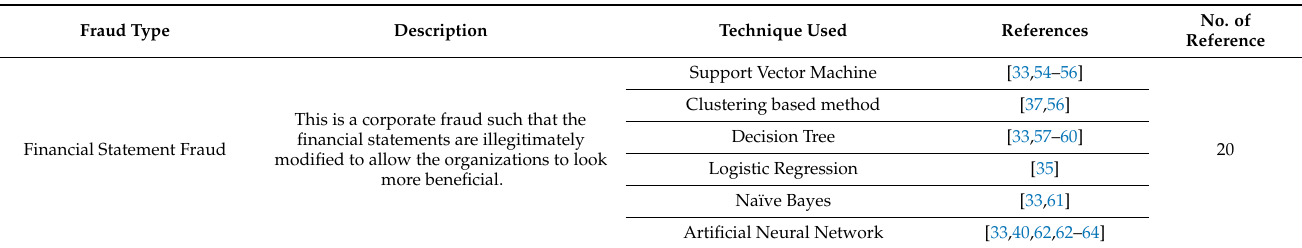
Table 5 show the different types of financial fraud. Table 5. Types of financial